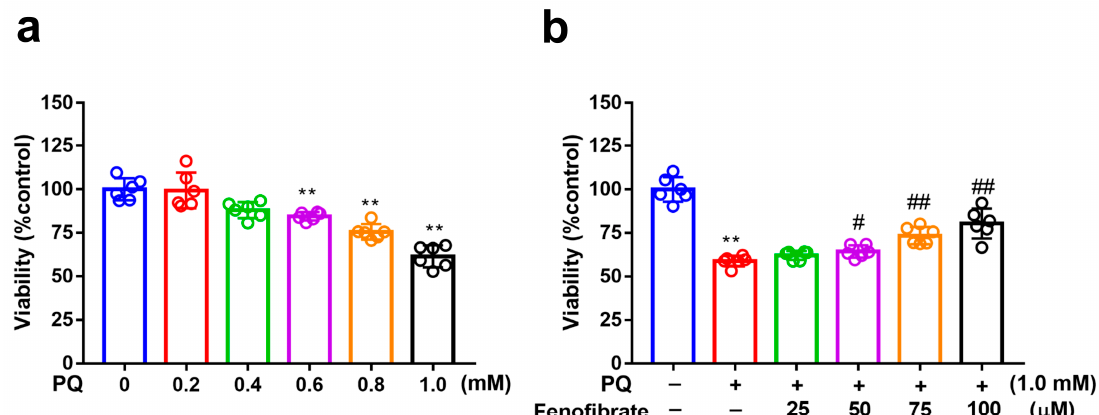
Figure 1. E ff ects of fenofibrate on cell viability in paraquat (PQ)-stimulated RF / 6A cells assessed using MTT assay. ( a ) Cell viability after exposure to di ff erent concentrations of PQ for 24 h. (** p < 0.01 among the control group and 0.6, 0.8, and 1.0 mM PQ-stimulated groups using Kruskal–Wallis test with post hoc Dunn’s test; n = 6 in each group) ( b ) Cell viability in PQ-stimulated RF / 6A cells with fenofibrate pre-treatment. RF / 6A cells were pretreated with di ff erent concentration of fenofibrate for 1 h, then exposed to 1.0 mM PQ for 24 h. (** p < 0.01 between the control group and 1.0 mM PQ-stimulated group using Mann–Whitney U-test; # p < 0.05, ## p < 0.01 compared to only 1.0 mM PQ-stimulated